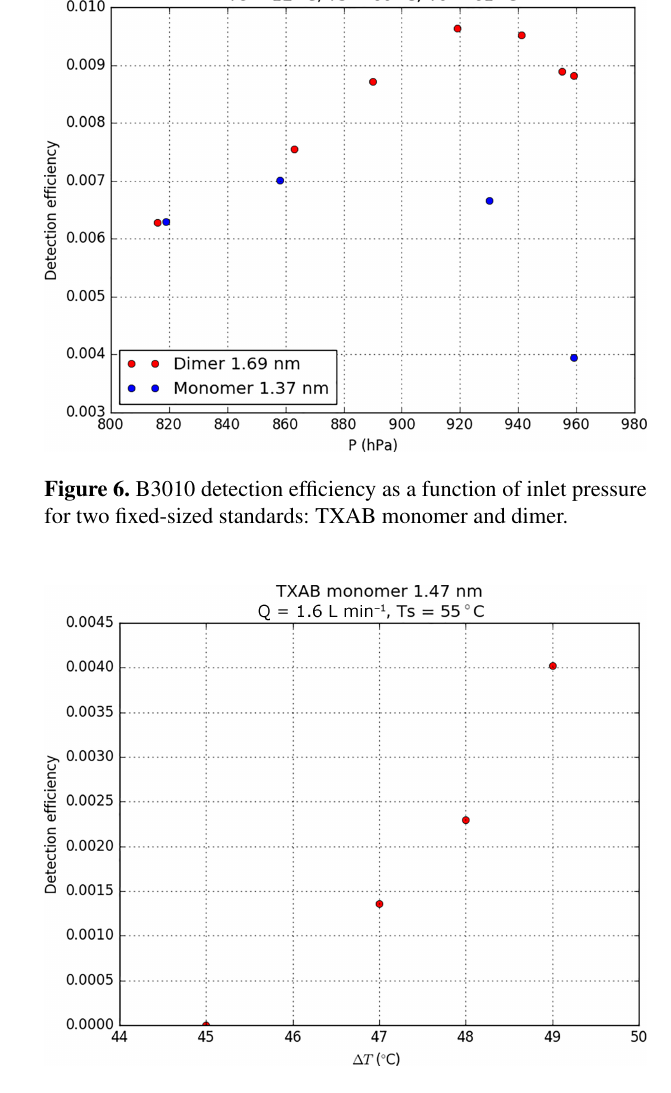
Figure 7. B3010 detection efficiency as a function of temperature gradient for TXAB